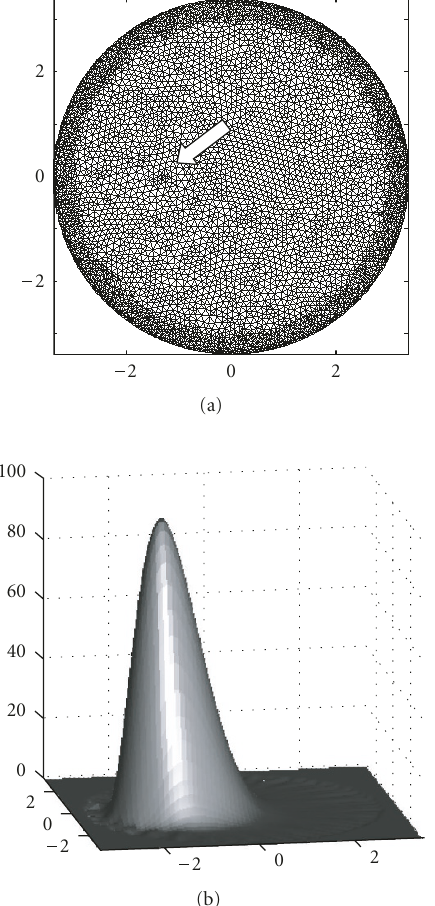
Figure 2: Simulation of the individual PSF: (a) high-resolution fi- nite element mesh with the compressed vicinity, (b) the simulation result corresponding to the